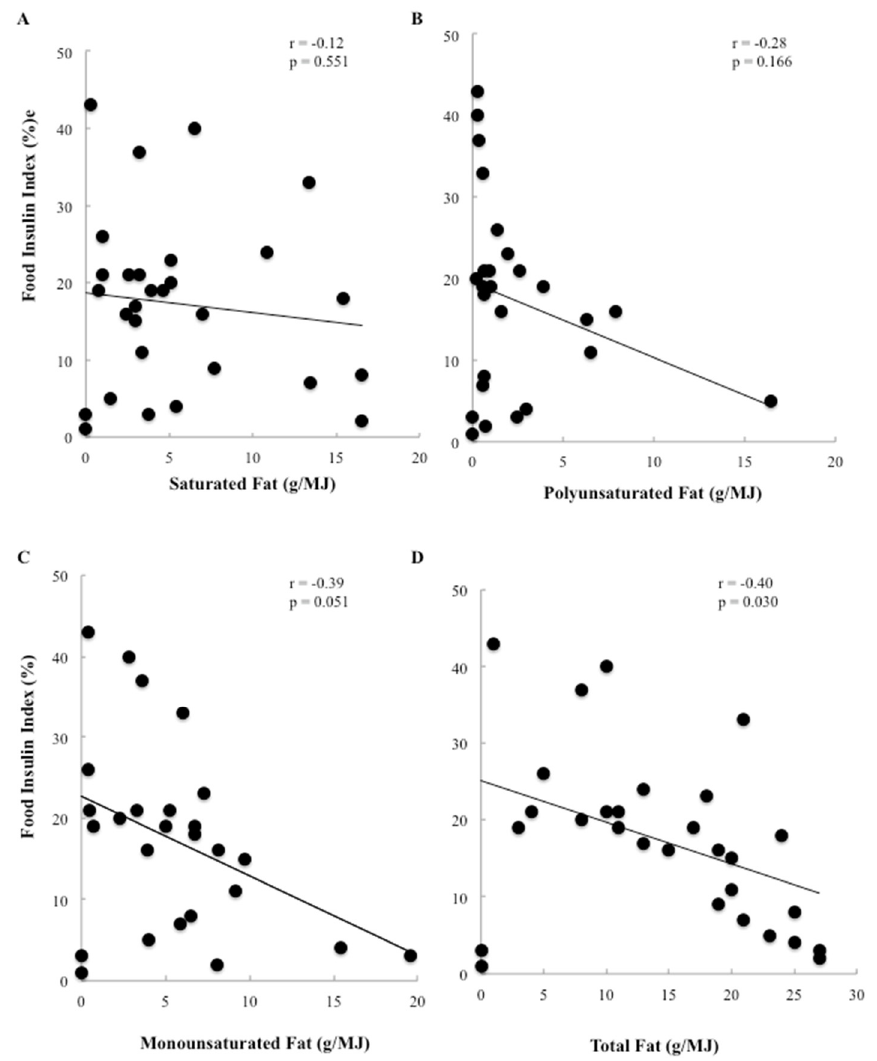
Figure 3. ( A – D ) Univariate correlations between the food insulin index and the total fat, saturated fat, polyunsaturated fat and monounsaturated fat for 1000 kJ portions of foods containing 10 g of available carbohydrate or less. A & B : n = 29 single foods, C & D : n = 27 single foods.